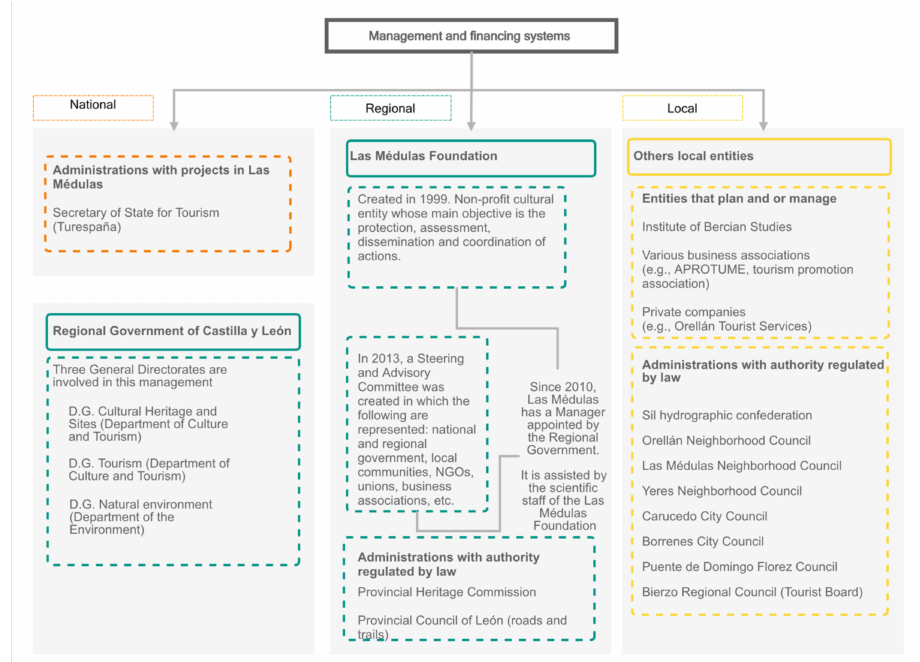
Figure 6. Management and financing systems Source: Author (cid:48) s own.